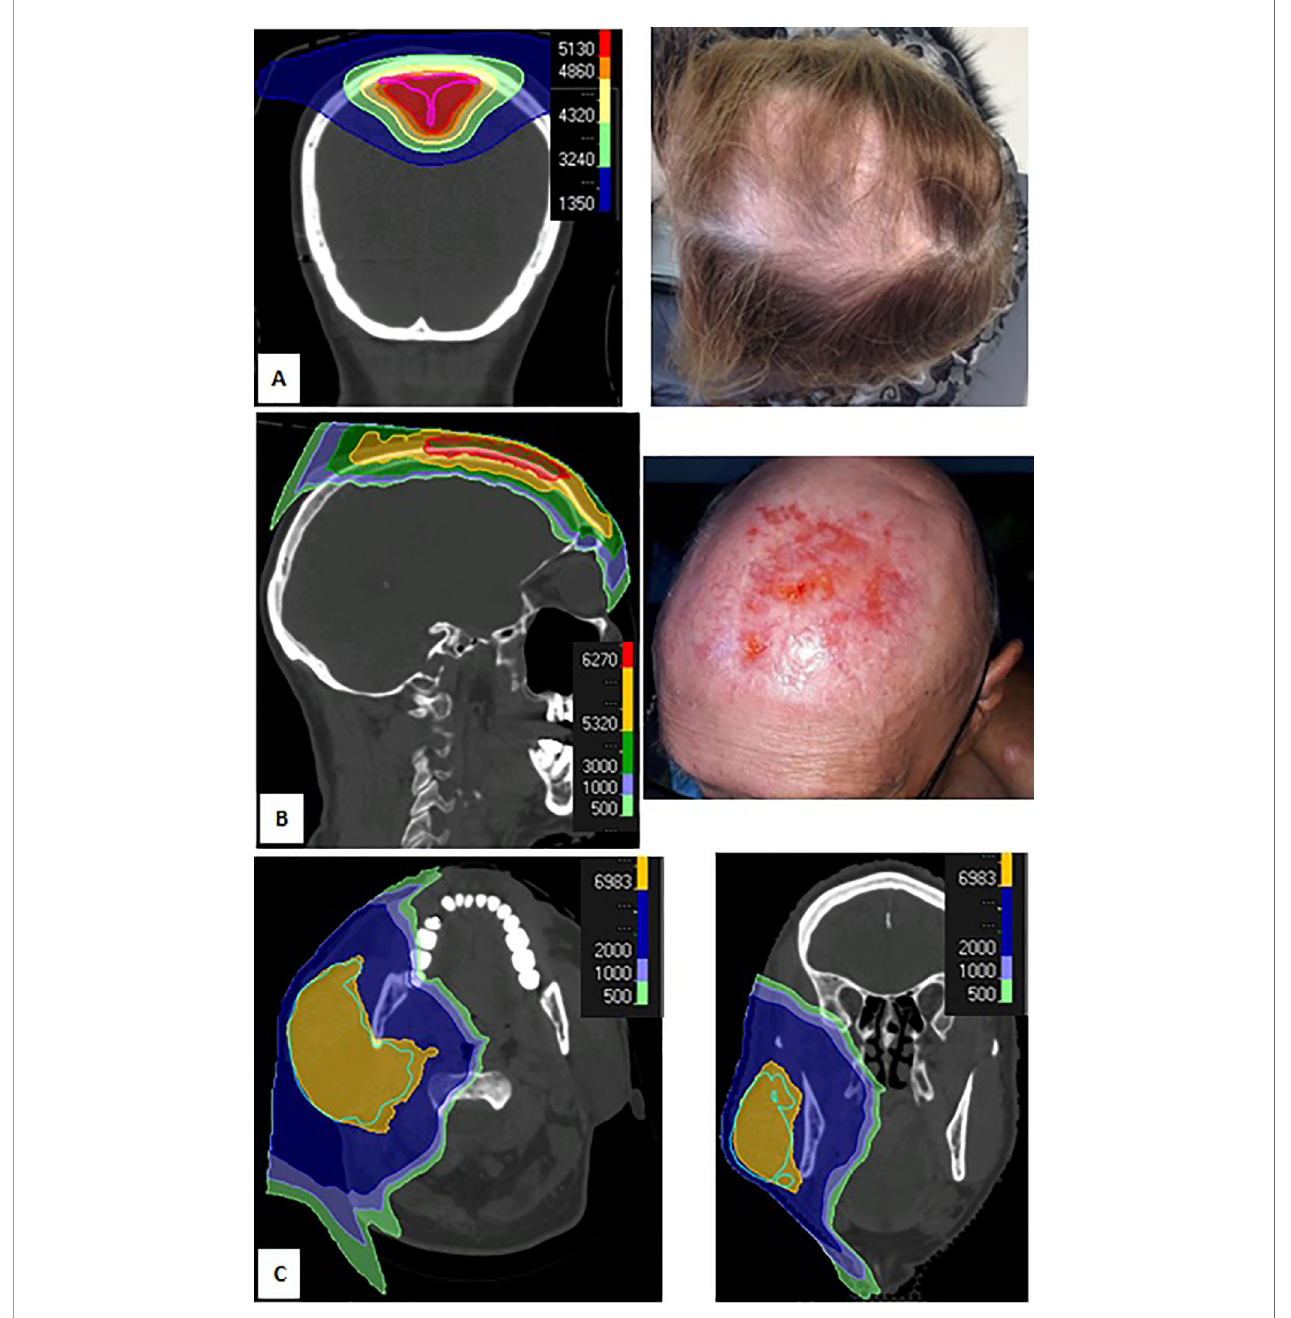
FIGURE 1 | Dose distribution ( A, left) and grade 1 alopecia ( A, right) during proton therapy (PT) of patient with meningioma; dose distribution ( B, Left) and grade 3 dermatitis ( B , right) 1 month after PT for Merckel carcinoma of the vertex; dose distribution for cystic adenoid carcinoma of the right parotid ( C, right, axial view; C, left, coronal